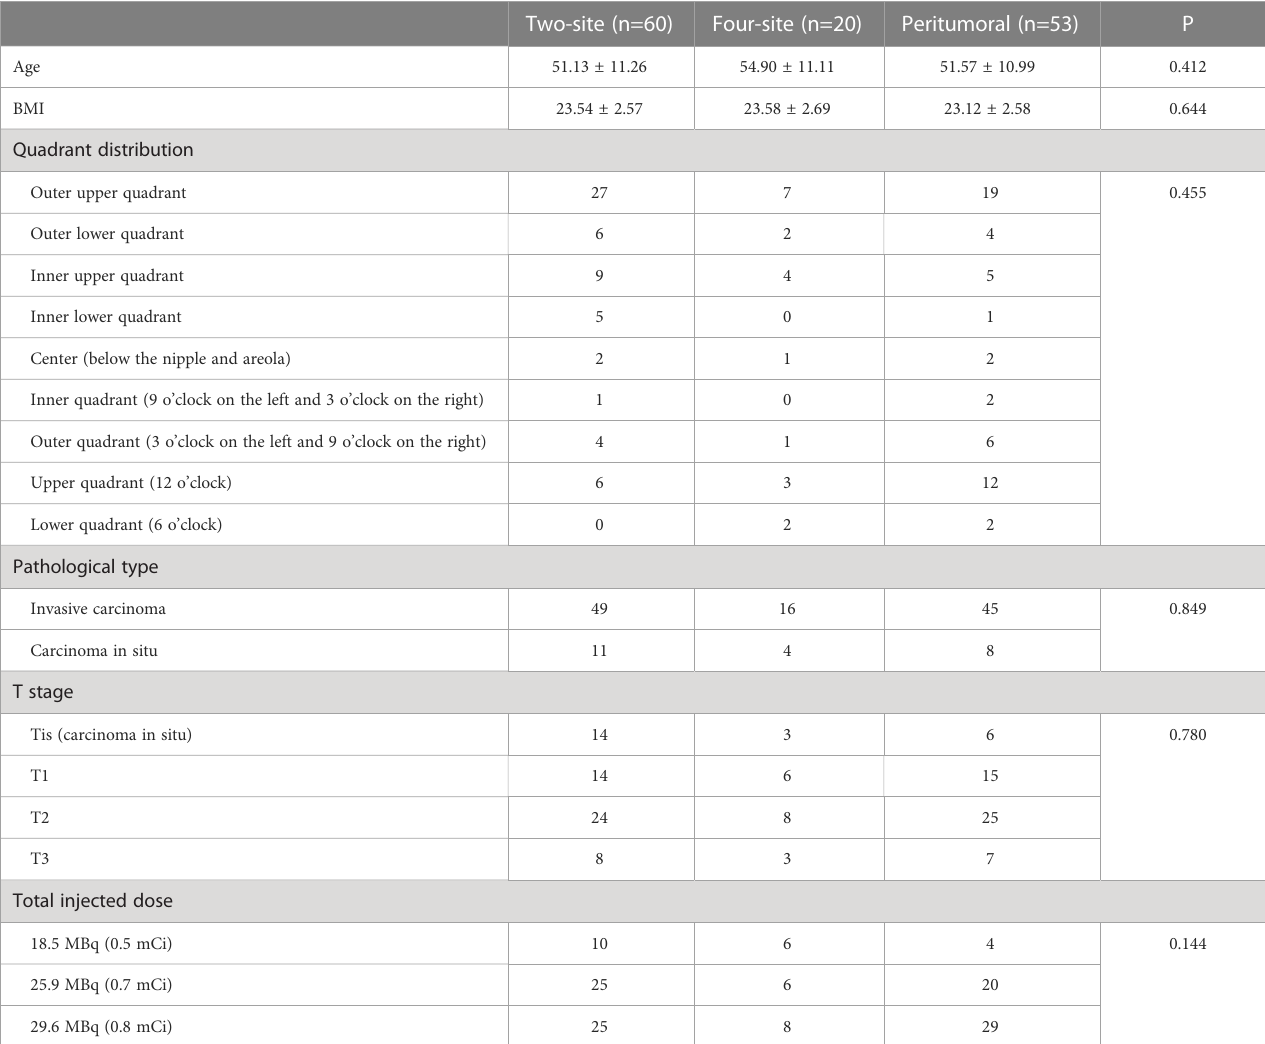
TABLE 1 Characteristics of the